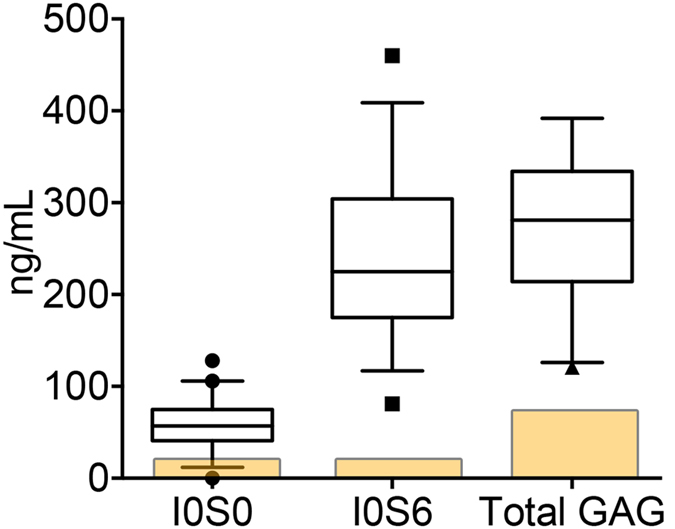
Non-reducing ends (NRE)s, I0S0 and I0S6, and total HS content in MPS-IH CSF.The boxes represent to 25th to 75th percentiles with a line at the mean. Whiskers show the 10th and 90th percentiles. Symbols represent value outside the 10 – 90th percentile. The yellow area indicates the normal range in the general population.